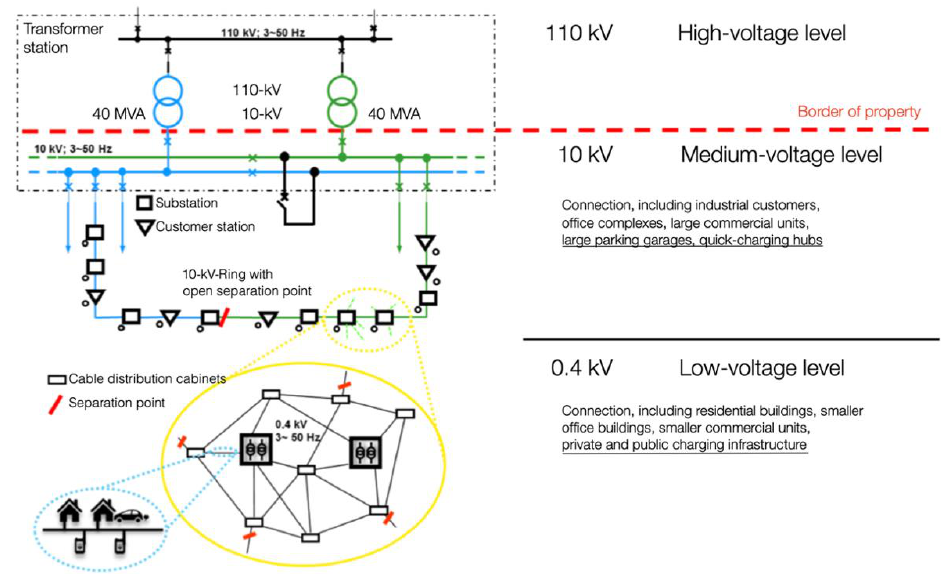
Figure 6. Schematic structure of electrical distribution network.